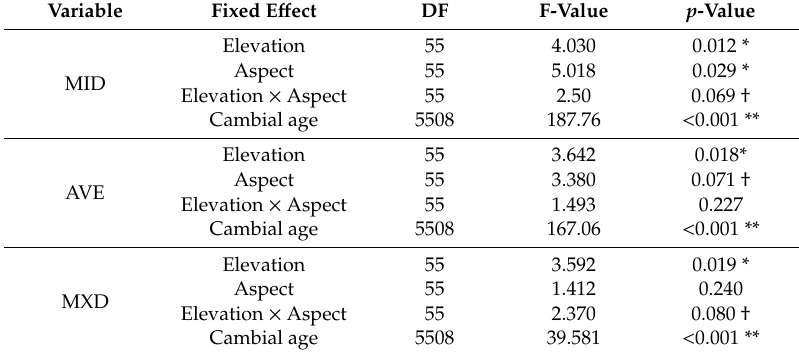
Table 2. Results of the analysis of variance on linear mixed-e ff ects models fitted to the tree-ring wood variables of Pinus hartwegii . In the analysis, trees and mountain sites were tested as random e ff ects. DF, degrees of freedom. Significance levels † p < 0.1, * p < 0.05, and ** p <